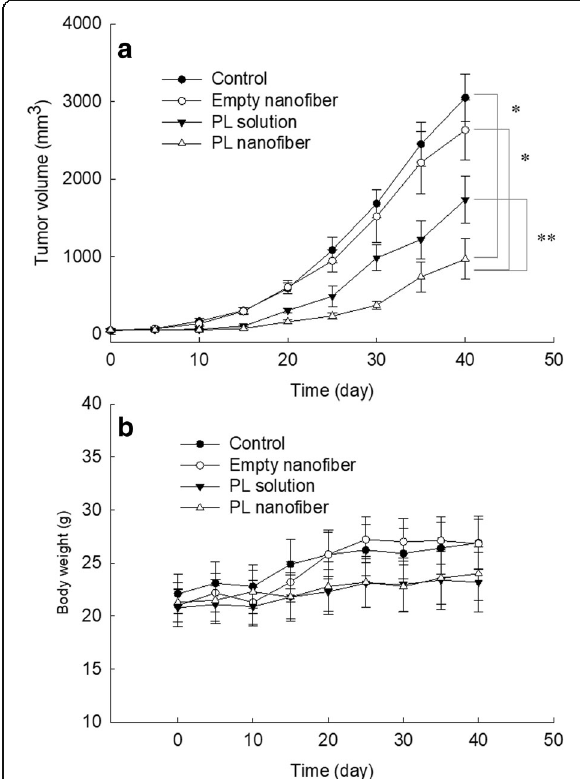
Fig. 7 The effect of PL solution, empty nanofiber mats or PL- incorporated nanofiber mats on the growth of HuCC-T1 tumor ( a ) and the body weight changes ( b ). HuCC-T1 (1 × 10 6 cells) cells were implanted to the back of mice. PL dose was adjusted to 10